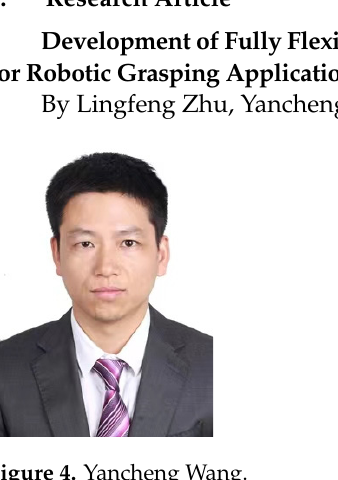
Figure 4. Yancheng Wang.